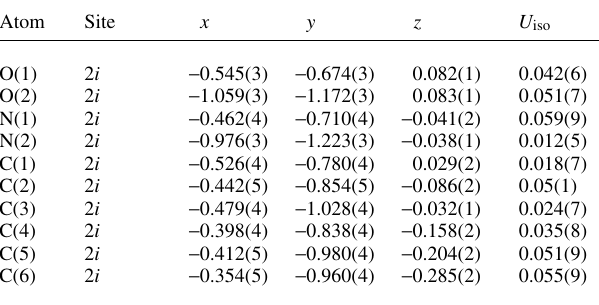
Table 2. Atomic coordinates and displacement parameters (in Å 2 ) .